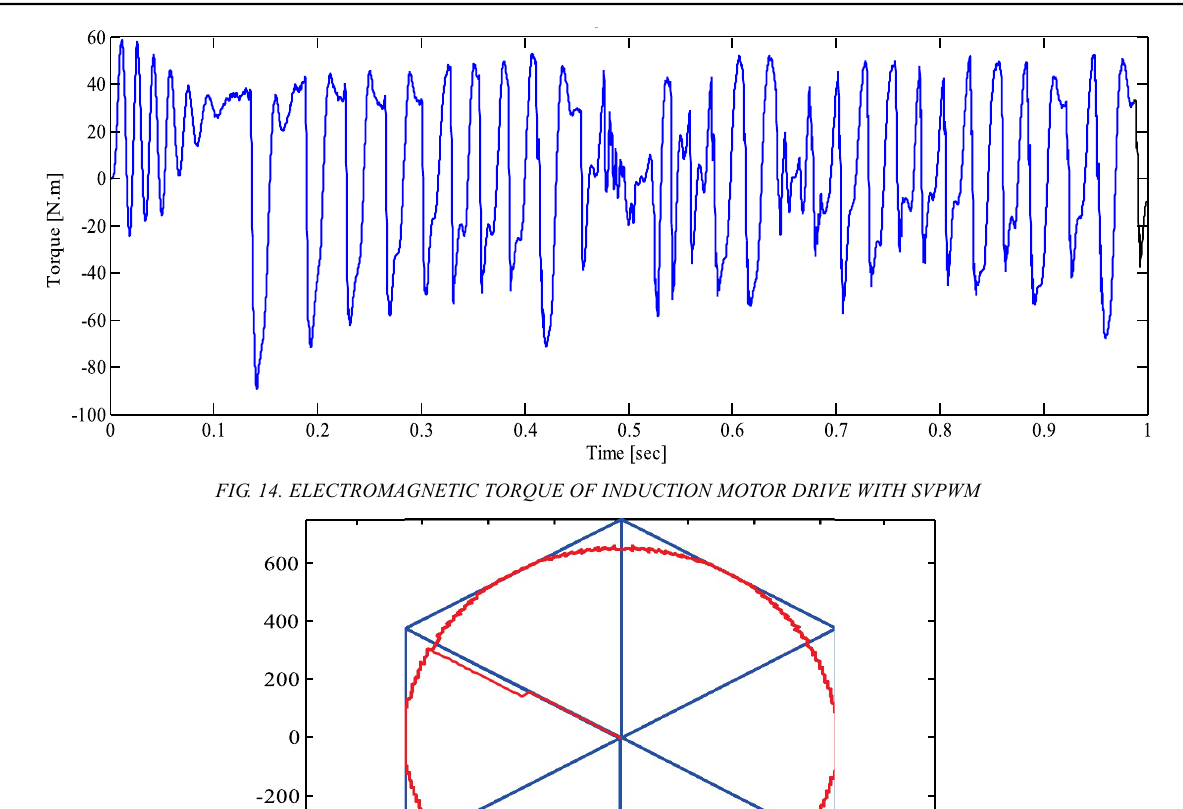
FIG.15 SPECE VECTOR TRAJECTORY